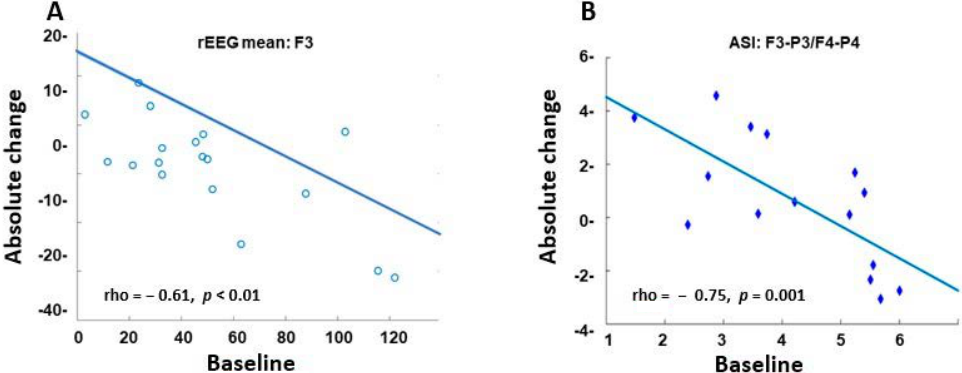
Figure 5. Correlation between the absolute change and the baseline. Scatterplot of the rEEG mean from channel F3 ( A ) and the ASI mean from channels F3-P3/F4-P4 ( B ) using Spearman ´ s test. Concordant results were found in the ASI analyses where the delta value was strongly and negatively correlated to the baseline in the interhemispheric F3P3-F4P4 (rho = − 0.753; p = 0.001) as well as the frontal comparison F3-F4 (rho = − 0.496; p = 0.038) (Figure